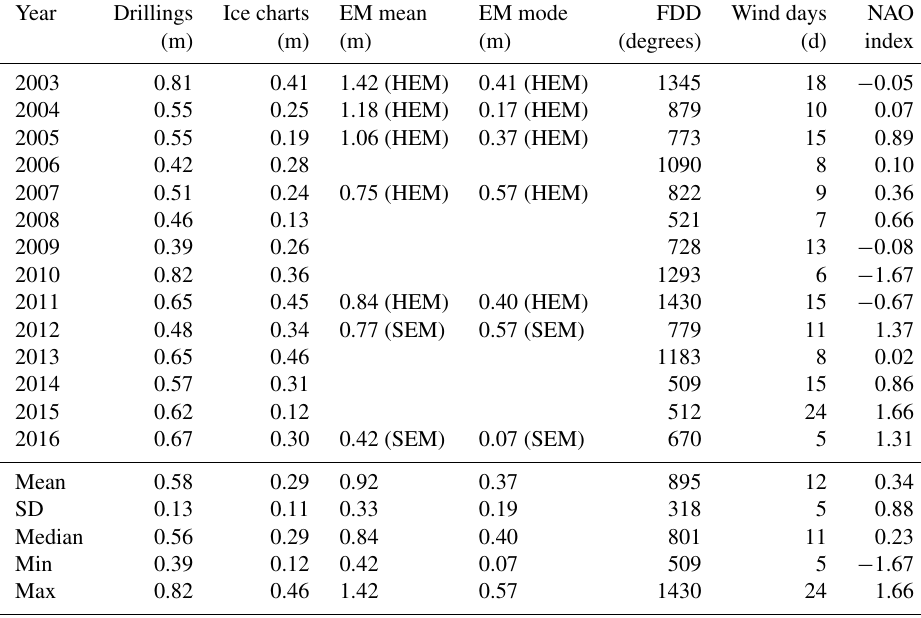
Table 4. Ice thickness observations, atmospheric variables, and their statistics from winters 2003 to 2016. Drillings are ice thickness drillings from Hailuoto approximately on 1 March, ice charts data is the mean from the area west of Hailuoto on 1 March (open water not taken into account), EM mean is the EM mean ice thickness in the same area, and EM mode is the mode thickness in the area. In EM data, HEM means helicopter-borne EM, and SEM means shipborne. FDD is the amount of freezing degree days during the winter in Hailuoto, wind days are days with wind over 14ms − 1 in JFM in Hailuoto, and NAO index is average value for winter months